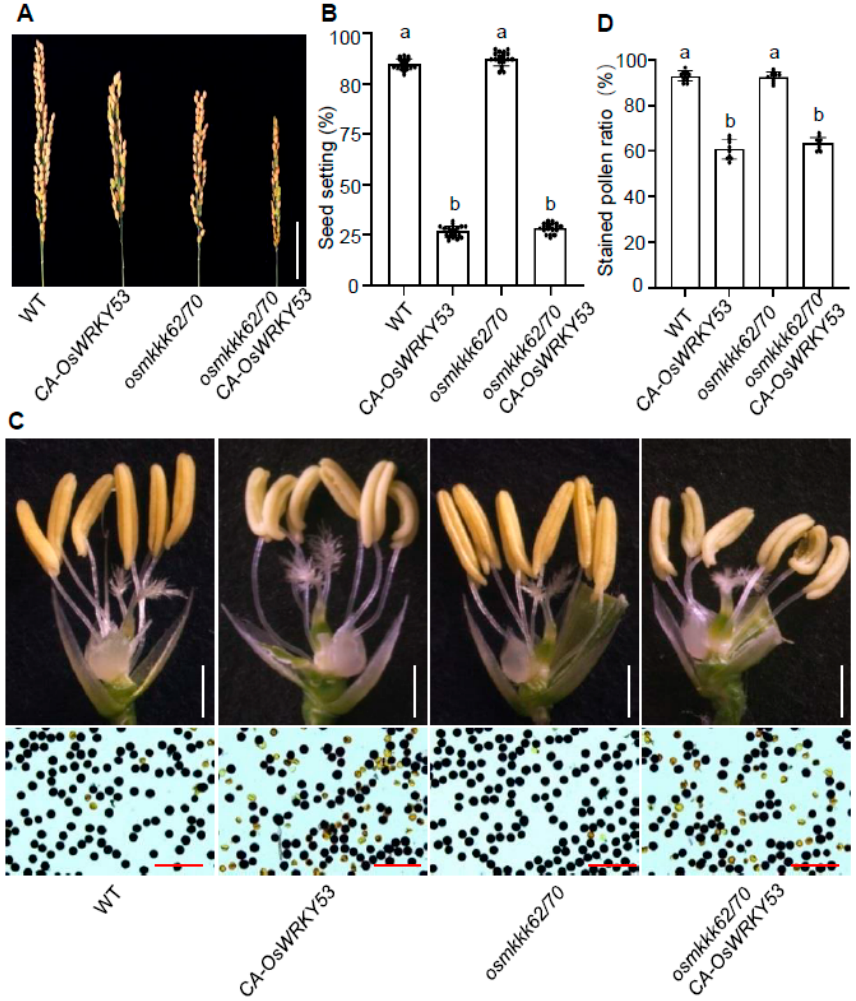
Figure 7. The phenotypic analysis of osmkkk62/70 CA-OsWRKY53 . ( A , B ) Representative images of panicles ( A ) and seed setting rate ( B ) of WT, CA-OsWRKY53 , osmkkk62/70 , and osmkkk62/70 CA-OsWRKY53 plants grown under NC. The scale bar in ( A ) is 5 cm. Data are shown as means ± SE (n = 30). ( C ) Representative images of anthers and stained pollen from WT, CA-OsWRKY53 , osmkkk62/70 , and osmkkk62/70 CA-OsWRKY53 plants grown under NC. The scale bars in the upper and lower images are 1 cm and 50 μ m, respectively. ( D ) Quantification of stained pollen ratio in WT, CA-OsWRKY53 , osmkkk62/70 , and osmkkk62/70 CA-OsWRKY53 plants. Data are shown as means ± SE (n = 10). Each dot represents the result from one biological replicate; error bars indicate means ± SE. Statistically significant differ- ences are indicated by different lowercase letters ( p < 0.05; one-way ANOVA with Tukey’s significant difference